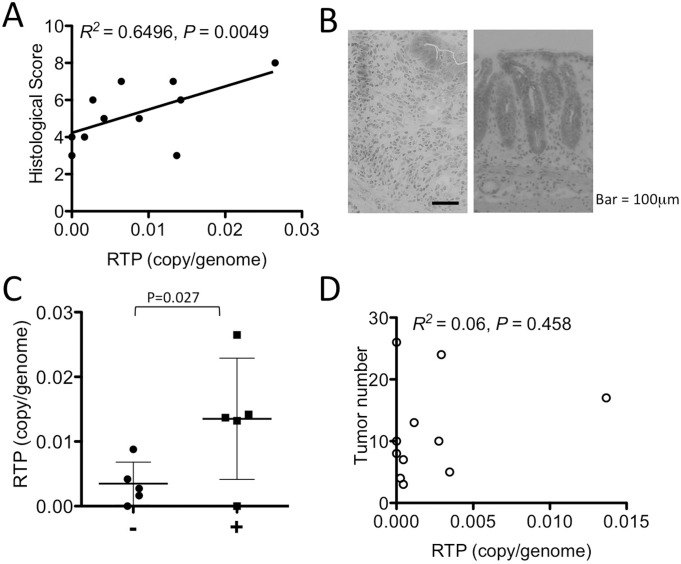
Correlation of the L1-RTP levels with histological scores, neutrophil infiltration, and tumor number.(A) The colitis histological score and L1-RTP levels in the whole distal colon during the acute phase mice showed a positive correlation. (B) Typical histological images of colitis with neutrophil infiltration (left) and without neutrophil infiltration (right) are shown. The bar represents 100 μm. (C) The L1-RTP levels were compared between the colon tissue without/with neutrophil infiltration into colon lamina propria during the acute and tumor phases. Data were shown as mean ± SD. The P value was calculated with an unpaired one-tailed t test. (D) The L1-RTP level of the background colonic mucosa and visible tumor numbers were not correlated.